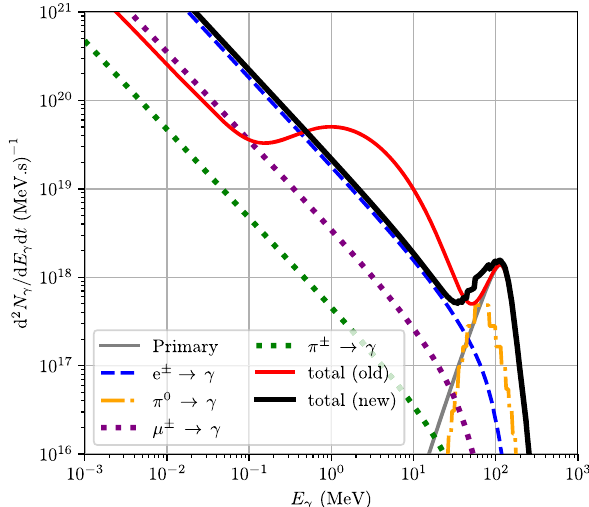
Fig. 4 Comparison between the old PYTHIA extrapolated (solid red) and new Hazma computed (solid black) BlackHawk instantaneous total photon spectrum for a M BH = 5 . 3 × 10 14 g. From left to right: primary photon spectrum (grey solid); neutral pion decay (orange dot- dashed);electronFSR(bluedashed);muondecay+FSR(purpledotted); charged pion decay+FSR (green dotted). To be compared with Fig. 2 upper left panel of [12]